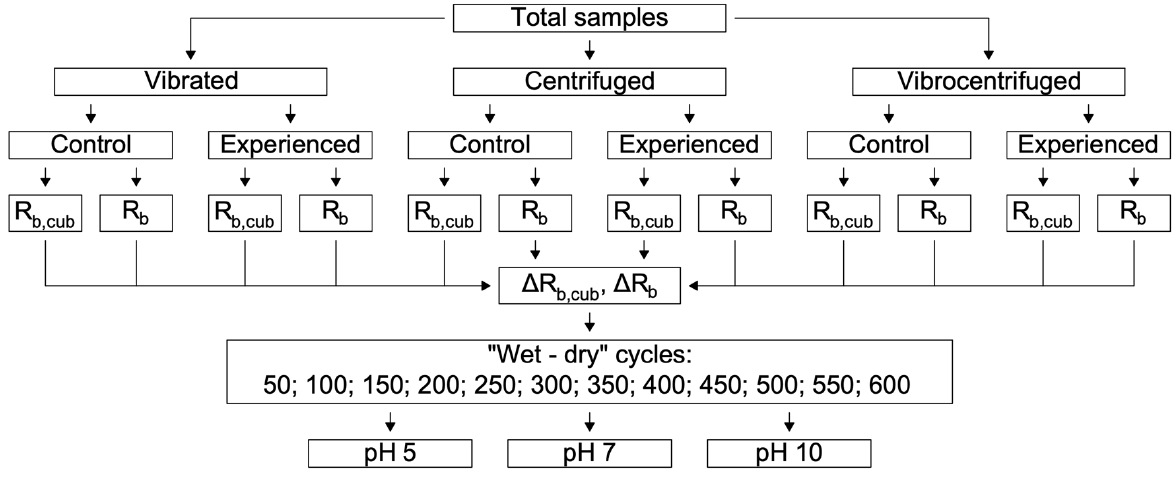
Figure 4. Block diagram of experimental studies.